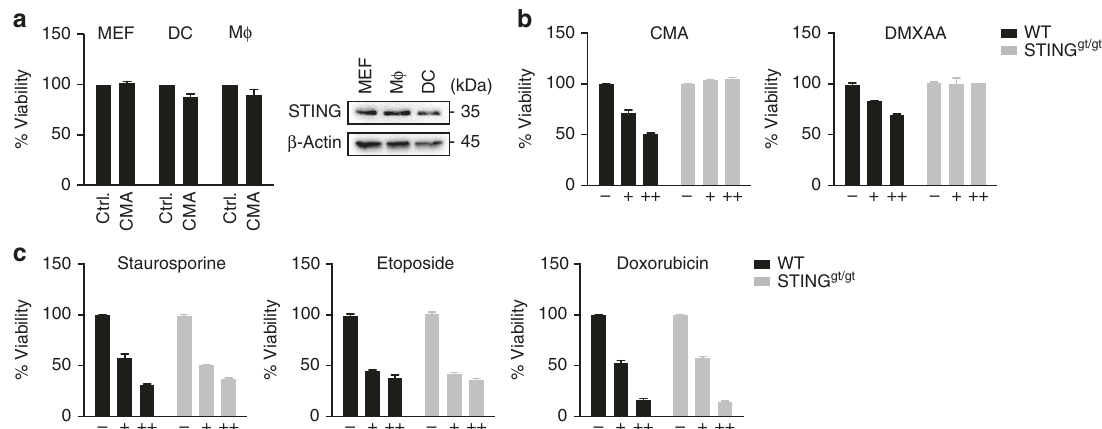
Fig. 2 STING activation induces apoptosis in a cell type-speci fi c manner. a Left: Primary mouse embryonic fi broblasts (MEF), bone marrow-derived macrophages (M Φ ) and bone marrow-derived DCs (DC) were treated with DMSO or 10-carboxymethyl-9-acridanone (CMA) and 16 h later cell viability was determined. Right: STING expression in distinct cell types was analysed by immunoblot. b , c CD4 + T cells from wild-type (WT) and STING gt/gt mice were left untreated or stimulated with CMA (0.125 mg/ml, 0.25 mg/ml), DMXAA (10 µ g/ml, 100 µ g/ml), staurosporine (100 nM, 500 nM), etoposide (1 µ g/ml, 5 µ g/ml) or doxorubicin (0.4 µ g/ml, 1 µ g/ml) overnight. Cell viability was assessed by CellTiter Blue assay. Representative results from n = 3 independent experiments ( a ; right panel) or mean and s.d. of technical replicates of one representative experiment out of n = 3 experiments are shown a – c . Unprocessed original blots are shown in Supplementary Fig.